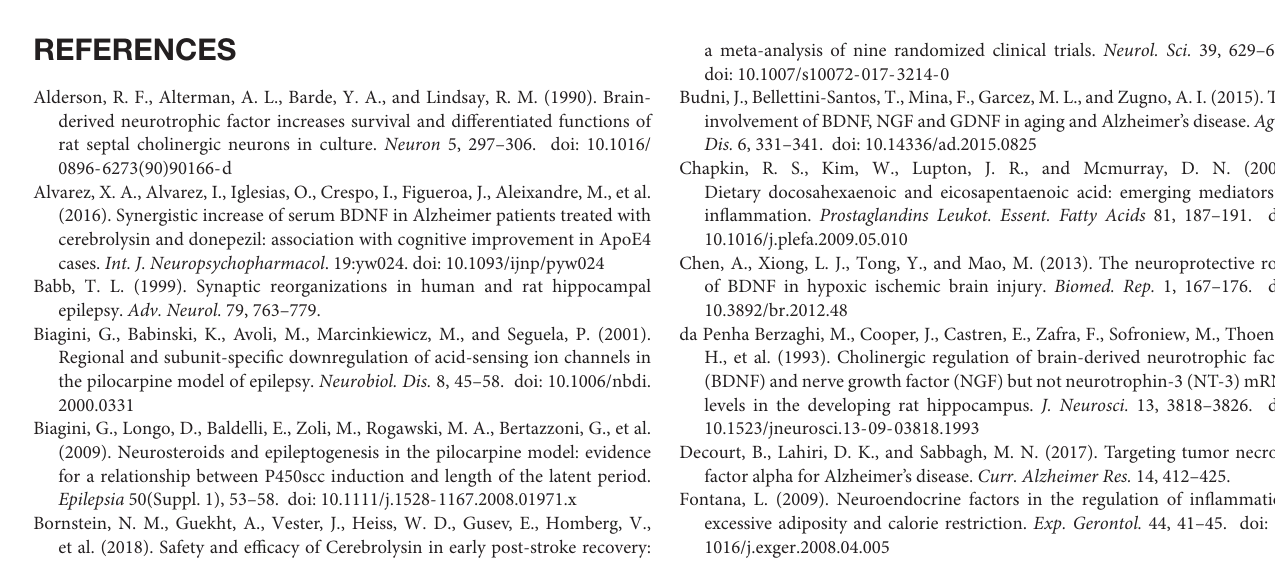
Supplementary Figure 1 | Pre-treatment of cerebrolysin has no anti-conversant effect on pilocarpine-induced